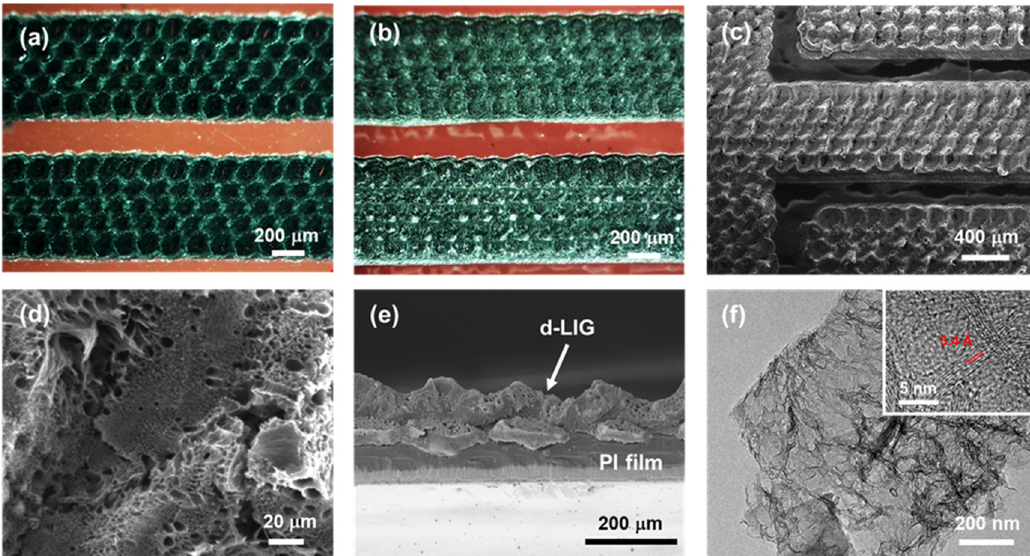
Figure 3. Optical image of an ( a ) LIG electrode obtained after the first laser pyrolysis and ( b ) d-LIG-MSC electrode. ( c ) SEM image of d-LIG-MSC electrodes from a top view, and ( d ) magnified SEM image of the d-LIG electrode surface. ( e ) Cross-sectional SEM image of a d-LIG electrode. ( f ) TEM image of a flake from the d-LIG, with an inset that shows a high-resolution TEM image of the d-LIG flake.